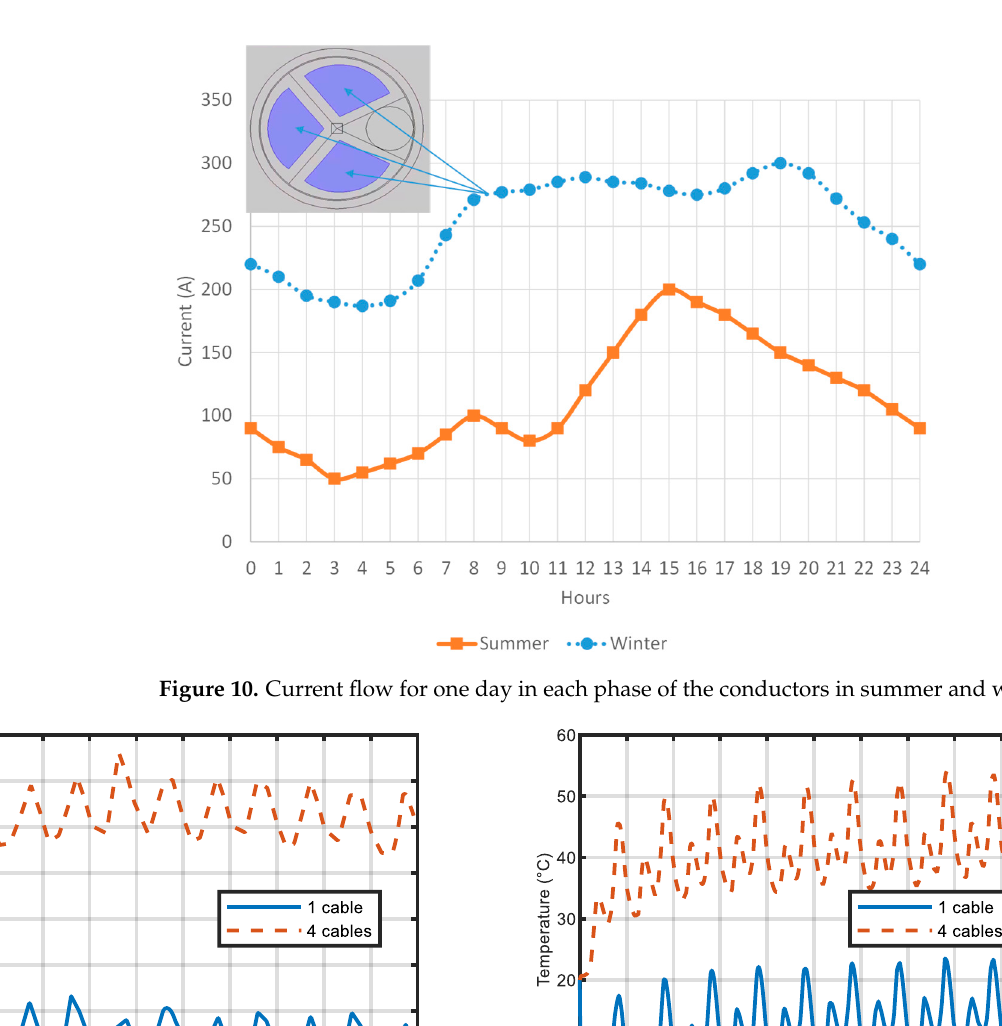
Figure 11. The temperature of cable(s) in summer ( a ) and winter ( b ).